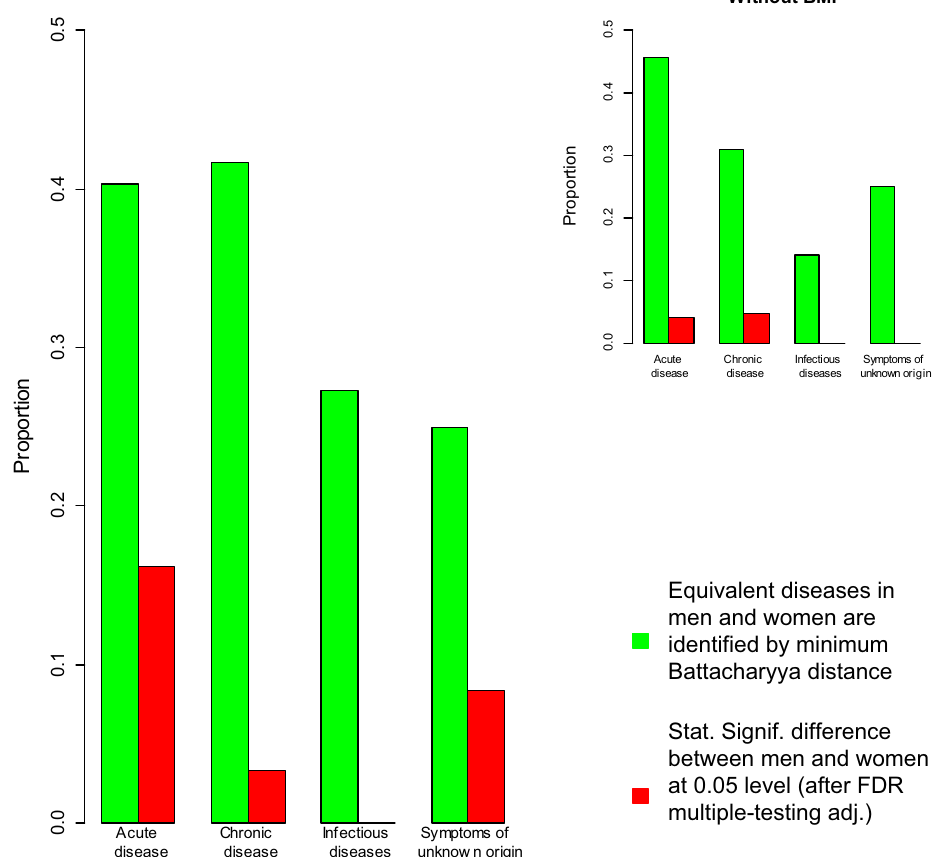
Figure 3. The proportion of diseases whose equivalent disease in the opposite sex has the smallest Bhattacharyya distance is plotted in green. The proportion of diseases with statistically significant differences between men and women are plotted in red. The differences are mainly due to different associations with BMI